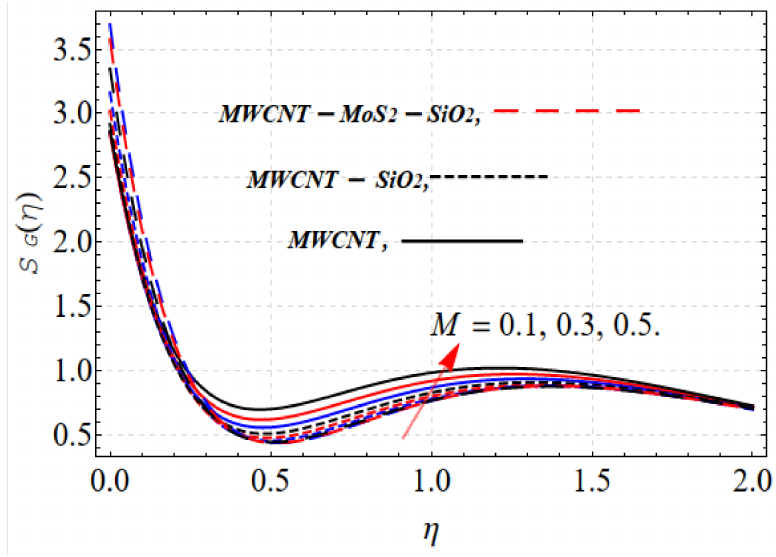
Figure 6. SG ( η ) vs. M